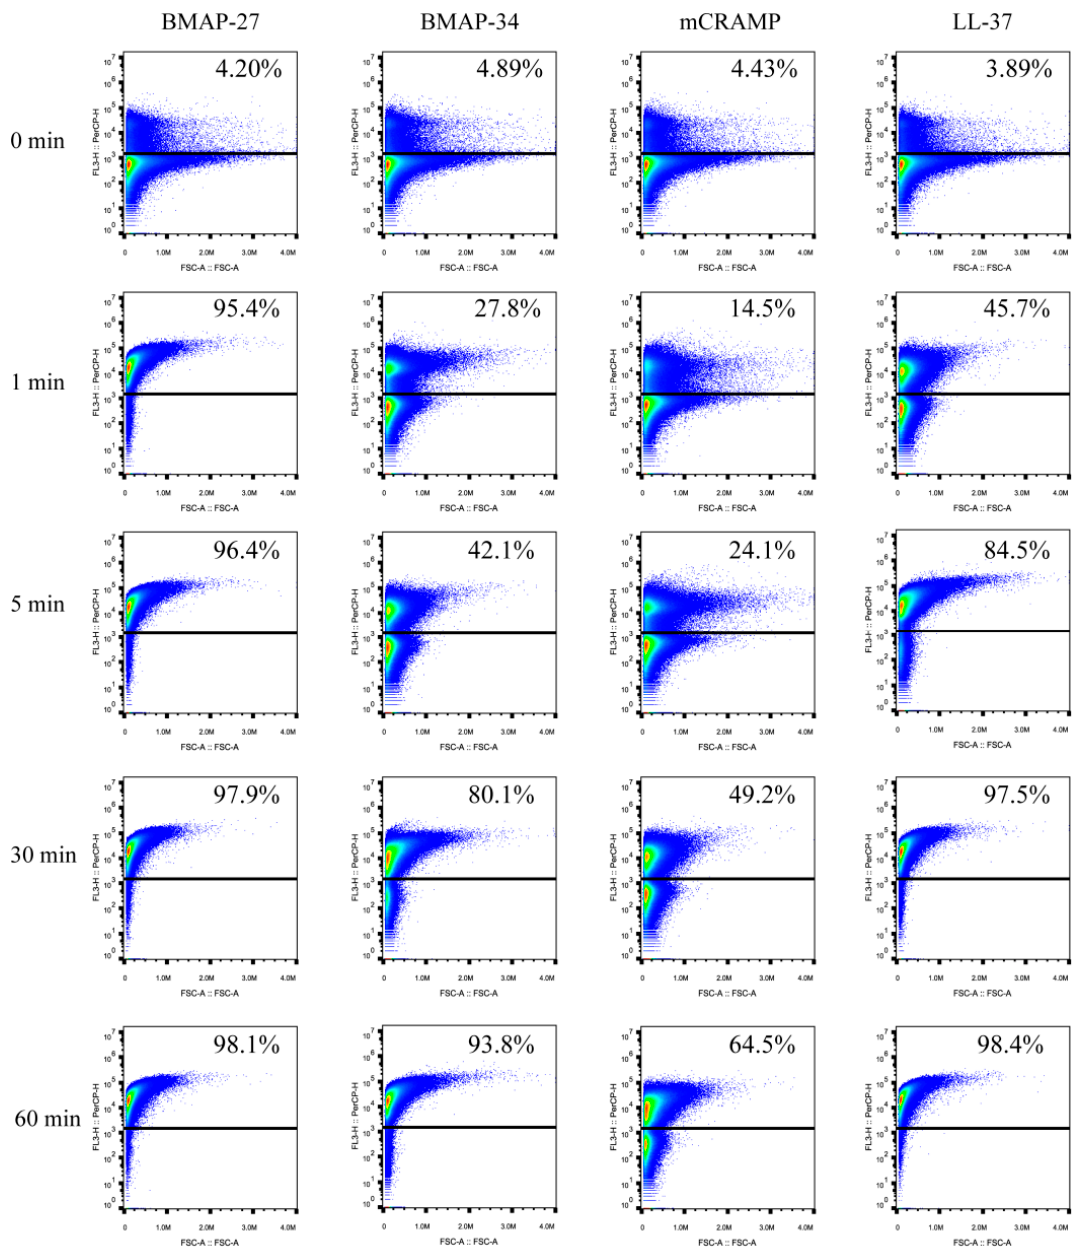
Figure 3. Mammalian cathelicidins rapidly penetrate the bacterial cell membrane. The membrane permeability of E. coli treated by 4 µ M of BMAP-27, BMAP-34, mCRAMP, and LL-37 as measured by an increase in fluorescence intensity of PI using a flow cytometry assay. A time-course membrane permeability was observed within 1 h.